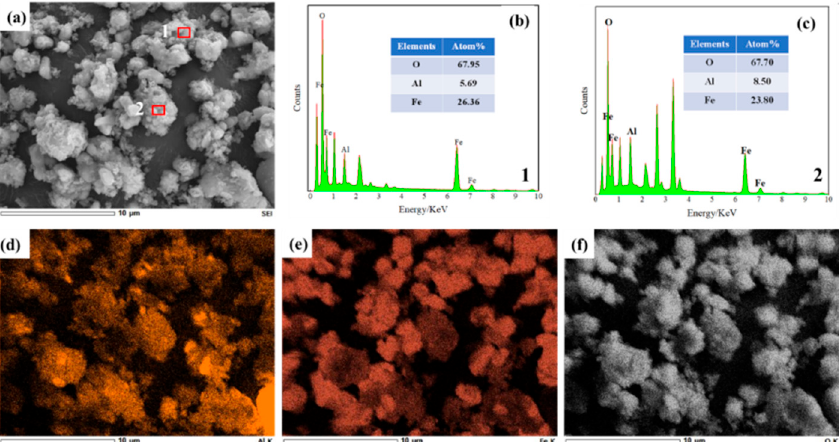
Figure 7. The SEM images of S 4 (mFe 2 O 3 /mAl 2 O 3 = 4:1) in ( a ), point spectrum for 1 in ( b ), point spectrum for 2 in ( c ), and the EDS spectrum of Fe in ( d ), Al in ( e ), and O in ( f ) at 2.3 V, 850 °C, and 4 h.